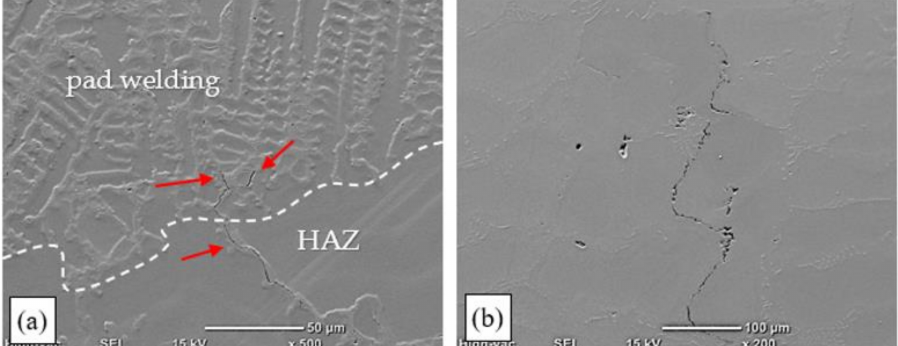
Figure 13. Structure of a remelted area in TIG remelting of Inconel 713C in a TecLine 8910 atmosphere (E l = 0.35 kJ/mm): ( a ) crack along crystal boundaries in the HAZ; ( b ) crack along dendrite boundaries in the carbide area